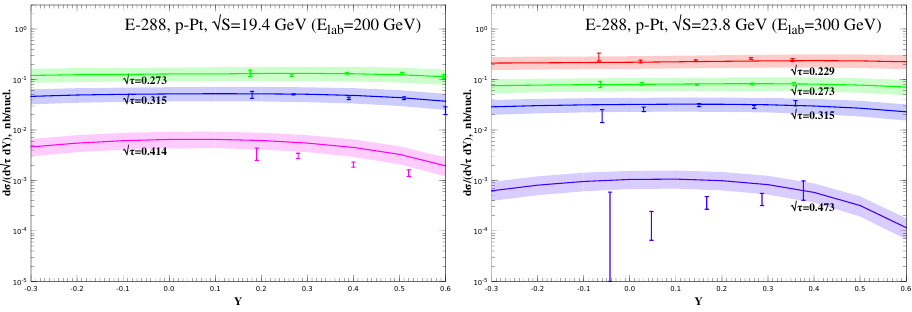
Figure 3. Rapidity spectra of DY pairs. The histogram corresponds to calculation in PRA. The data are from the E288 Collaboration [14], left panel: